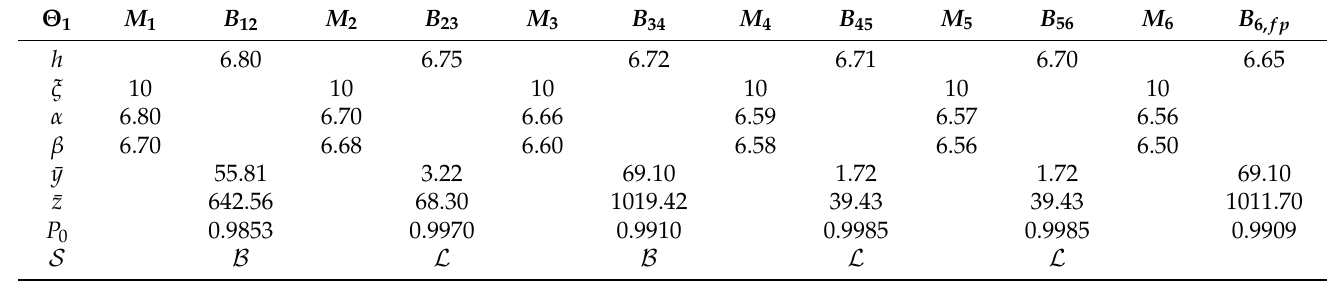
Table 3. Parametric values and results obtained from the one by one format.